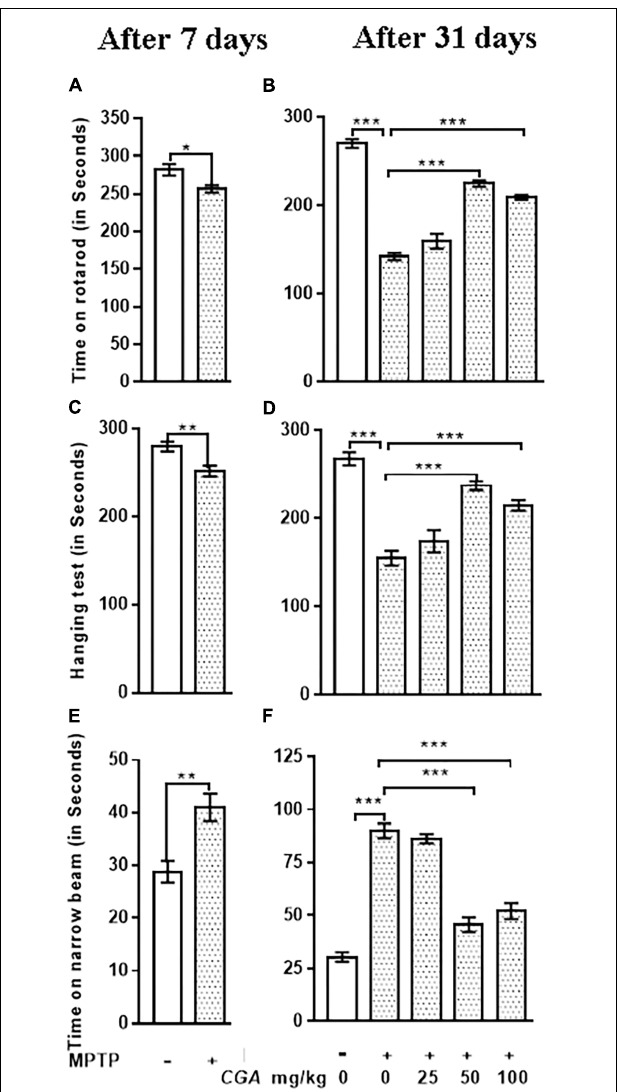
FIGURE 2 | Effect of chlorogenic acid on behavioral parameters. (A) Rotarod test of mice was performed after 7 days from MPTP intoxication in control and MPTP groups. The time on the rotarod was found to be decreased in MPTP-intoxicated group compared with control. (B) After the completion of dosing, a significant improvement in the time of stay on rotarod was found in CGA-treated mice compared with the MPTP-intoxicated group. MPTP group shows reduced time of walking and staying on rotarod compared with the control group. (C) Hanging test was performed after 7 days from MPTP intoxication in control and MPTP groups. The hanging time was found to be reduced in MPTP-intoxicated groups compared with control. (D) After the completion of dosing, a significant improvement in the hanging time was observed in the CGA-treated group compared with the MPTP-treated group. MPTP group mice fall early compared with the control group. (E) Narrow beam walking test was performed after 7 days from MPTP intoxication in control and MPTP groups. The narrow beam walking time was found to be increased in MPTP-intoxicated groups compared with control. (F) In contrast, CGA treatment declines the walking time against MPTP-induced phenotype in mouse after the completion of dosing. Data are expressed in terms